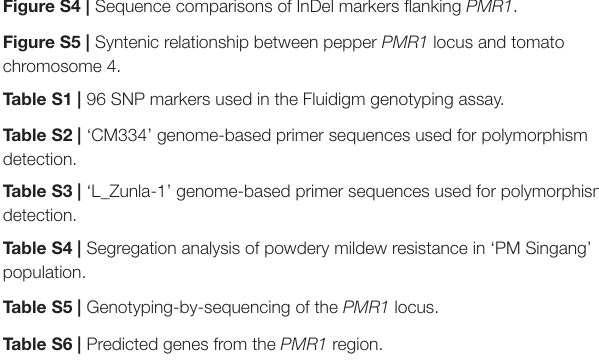
Table S5 | Genotyping-by-sequencing of the PMR1 locus. Table S6 | Predicted genes from the PMR1